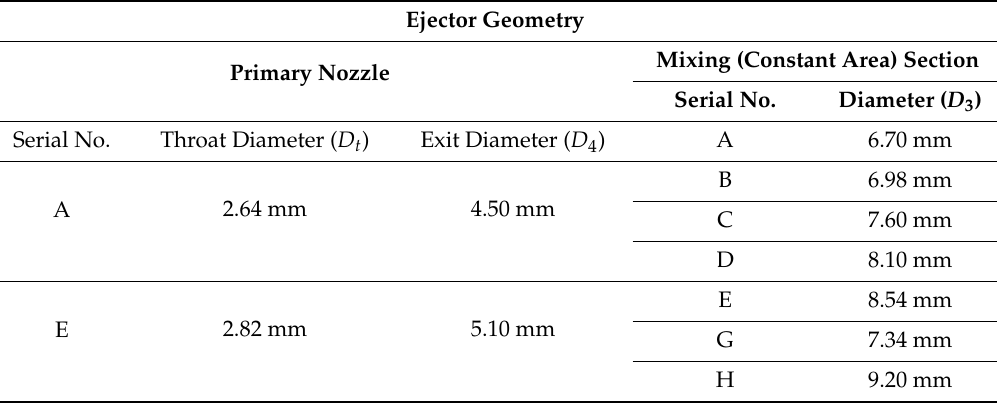
Table 1. Geometrical specifications of ejector.